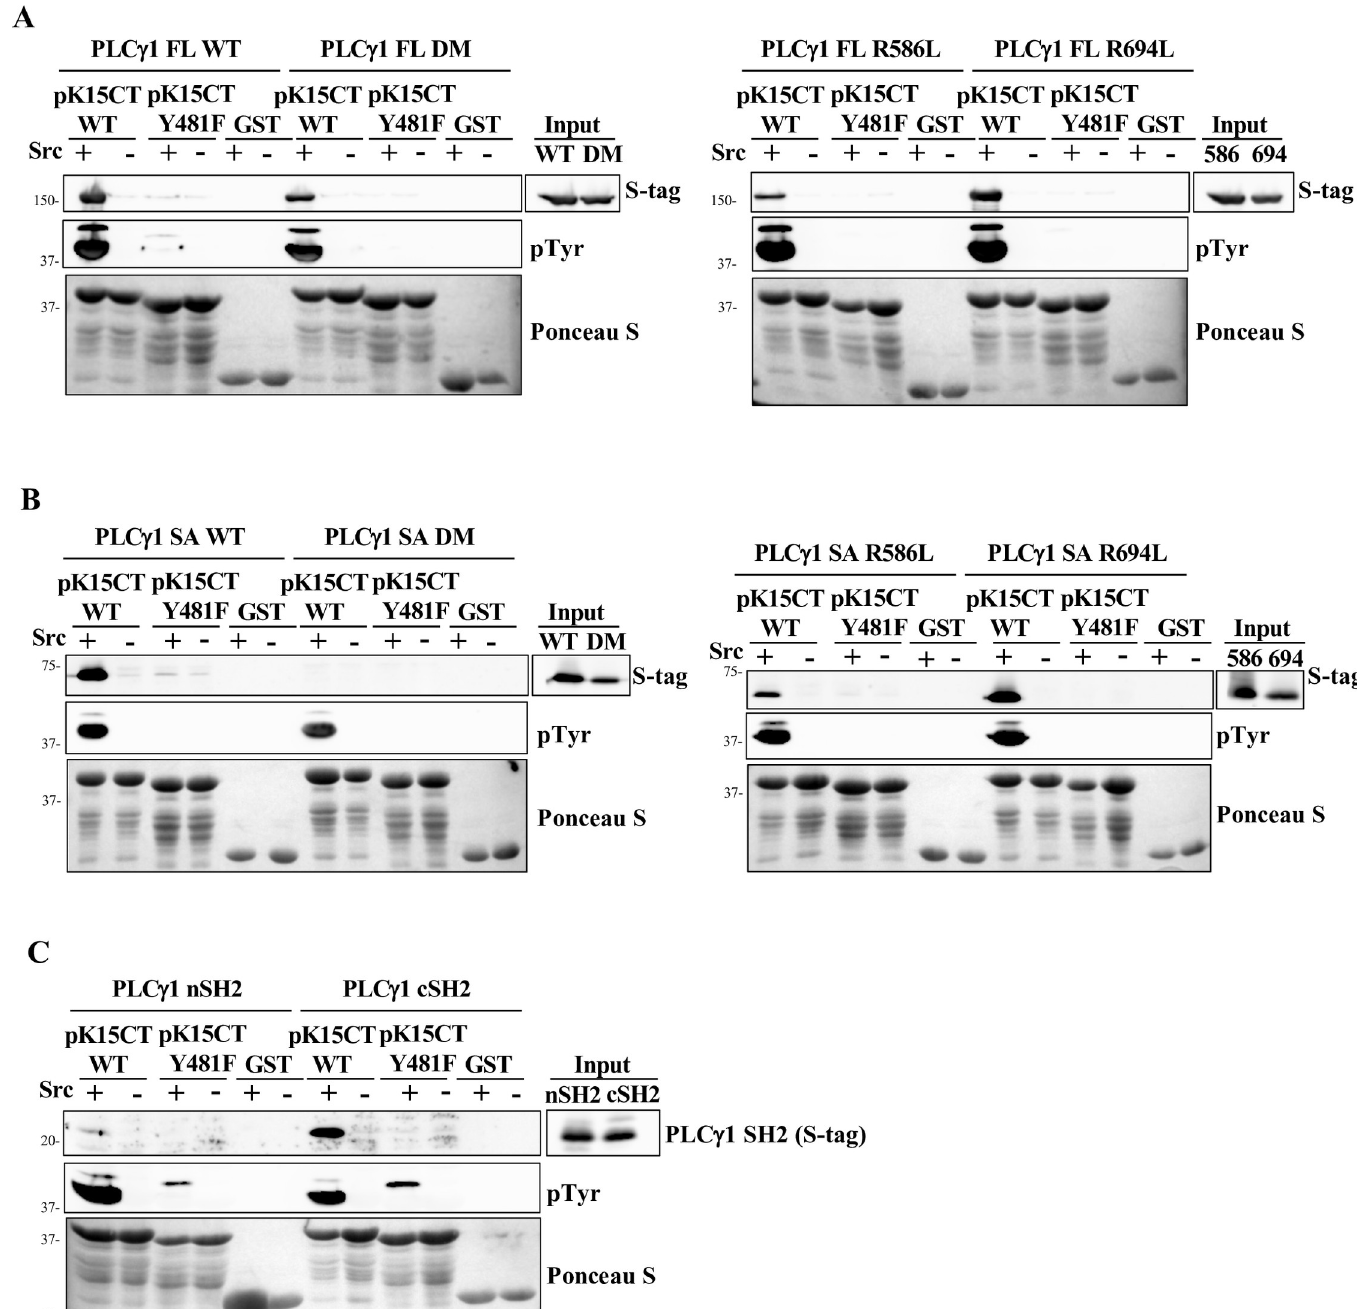
Fig 3. Contribution of individual PLC γ 1 SH2 domains to the interaction with phosphorylated pK15. The pK15 CT fused to GST, its Y 481 F mutant, or GST alone were bound to glutathione beads, phosphorylated in vitro (+) or left unphosphorylated (-), and a GST pulldown was performed 32h after transfection into HEK-293T cells of expression vectors for S-tagged full-length PLC γ 1 (FL) (A) or PLC γ 1 SA (B) containing the indicated mutations. (C) pK15 CT WT, its Y 481 F mutant or GST were bound to glutathione beads, phosphorylated in vitro (+) or left unphosphorylated (-), and used for a GST pulldown assay 32h after transfecting HEK 293T cells with expression vectors for S-tagged individual PLC γ 1 nSH2 or cSH2